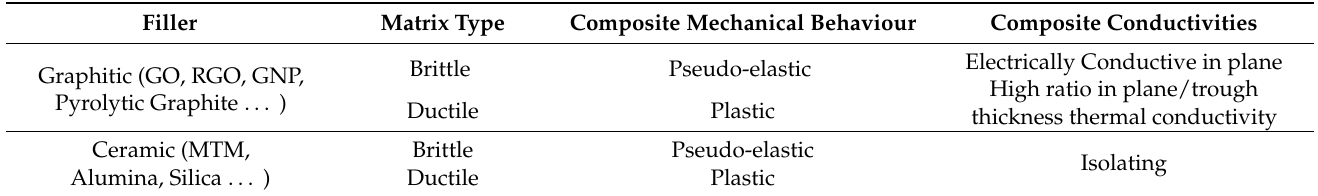
Table 1. Mechanical and functional behaviour of composites with high content 2D nanofiller accord- ing to reinforcement nature.